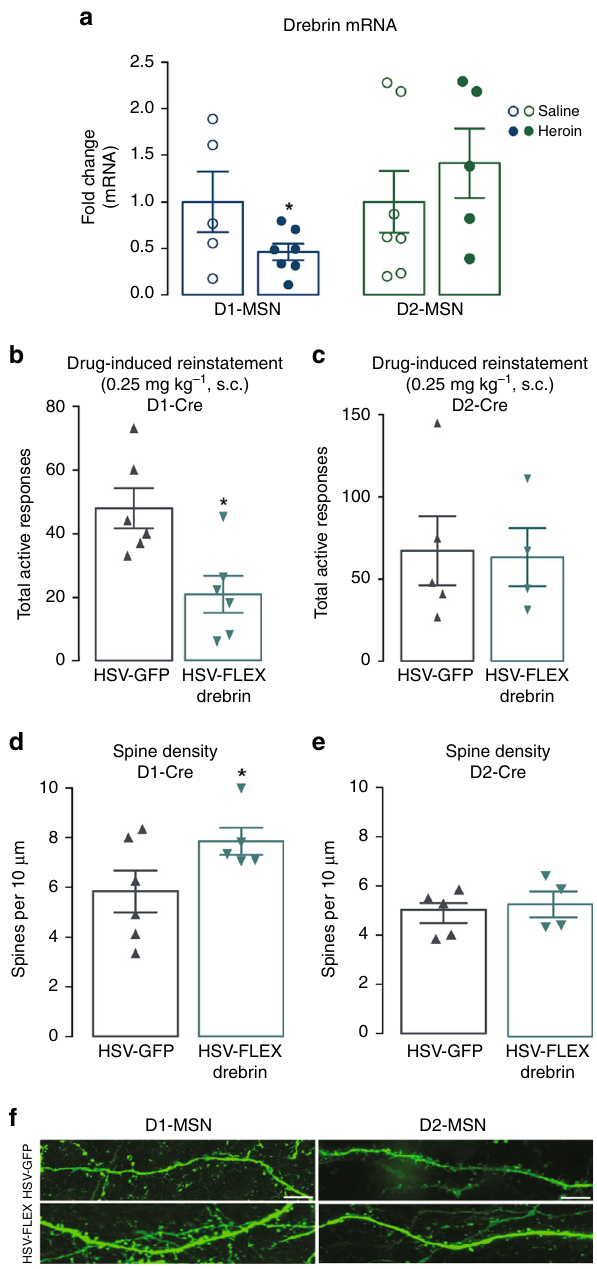
Fig. 5 Cell-type-speci fi c expression of drebrin alters behavioral